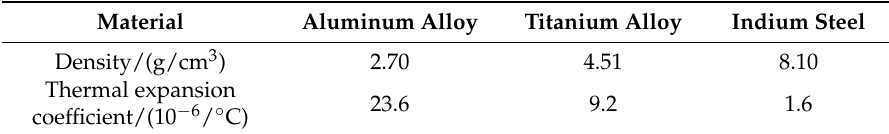
Table 2. Material properties of mechanical structure.